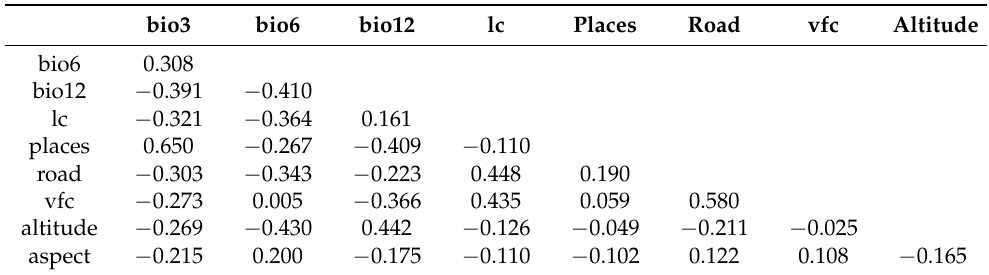
Table 2. Correlation analysis of nine environmental factors on a geographic scale in Liupanshan National Nature